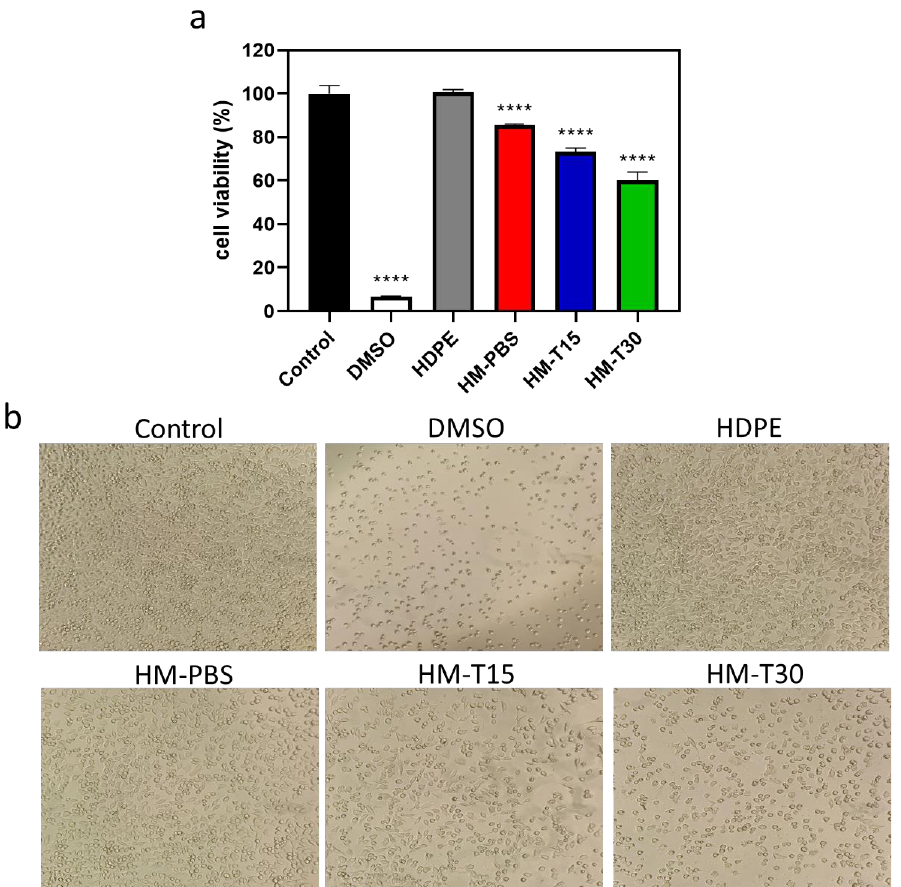
Figure 6. ( a ) Cell viability in the extracted medium of HM, HM-T15, and HM-T30 through 24 h extrac- tion and 24 h L-929 cell culture ( n = 3). One-way ANOVA, **** p < 0.0001 compared with the control group. ( b ) Images of L-929 cells cultured in HM, and HM-T extract for 3 h, and irradiation for 15, and 30 minutes. The images were photographed after 24 h incubation.